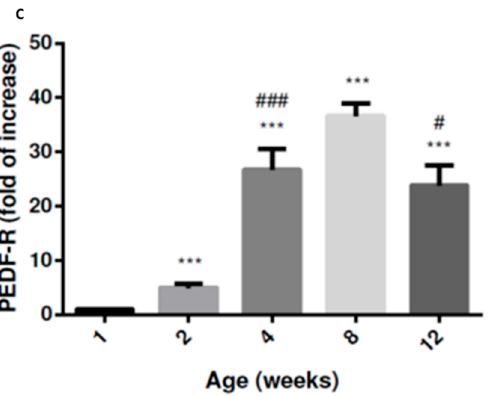
Figure 4. Cellular localization and expression levels of PEDF receptor (PEDF-R) in testicular tissue and cells. Paraffin embedded testicular tissue from 2-week-old mice ( A ) and 4-week-old mice ( B ) were used as described in Figure 1. Fixed sections were immunofluorescence stained for PEDF-R with specific antibodies (red) and DAPI (blue). NC were stained in the absence of the primary antibody. The expression levels of PEDF-R in testicular homogenates were evaluated by qPCR with specific primers ( C ). ∗ —Statistical significance of mice in comparison to 1w. #—Statistical significance of mice in comparison to previous age. N = 4–6. N—number of mice used for testis homogenates repeat. ∗∗∗ — p < 0.001. #— p < 0.05, ###— p < 0.001. Scale bar: 100 μ m.